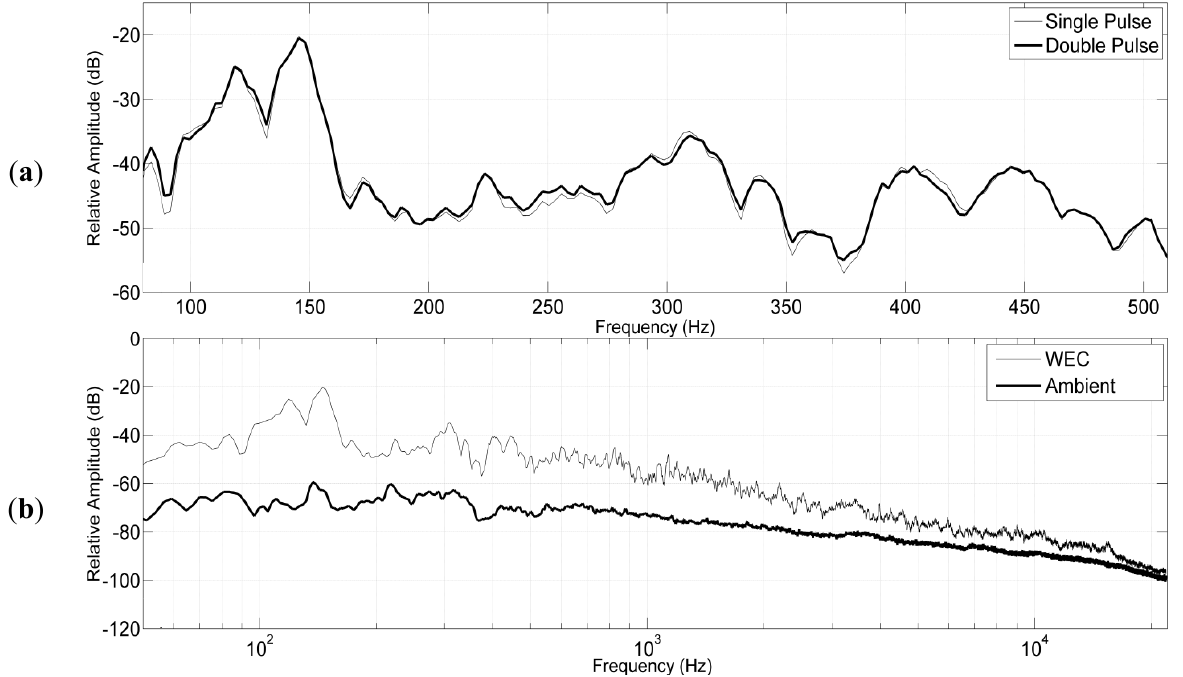
Figure 10. ( a ) Comparison between spectrums of single and double pulses. The single pulse line is the average line of N = 50 and double pulse line is the average of N = 30; ( b ) Comparison between ambient noise. The single pulse line is the average line of N = 50 and ambient noise line is the average of N = 30. Frequency on the x -axis and amplitude on the y -axis.